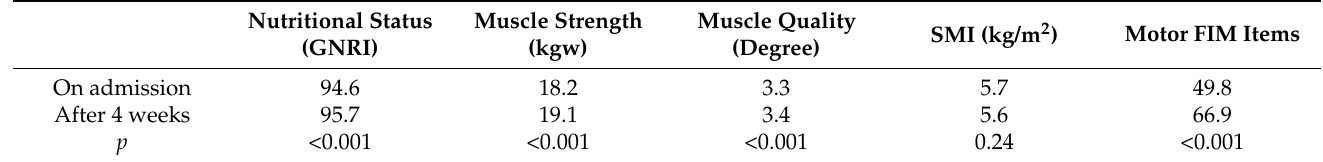
Table 4. Changes in nutritional status, muscle strength, quality, and SMI in female patients.